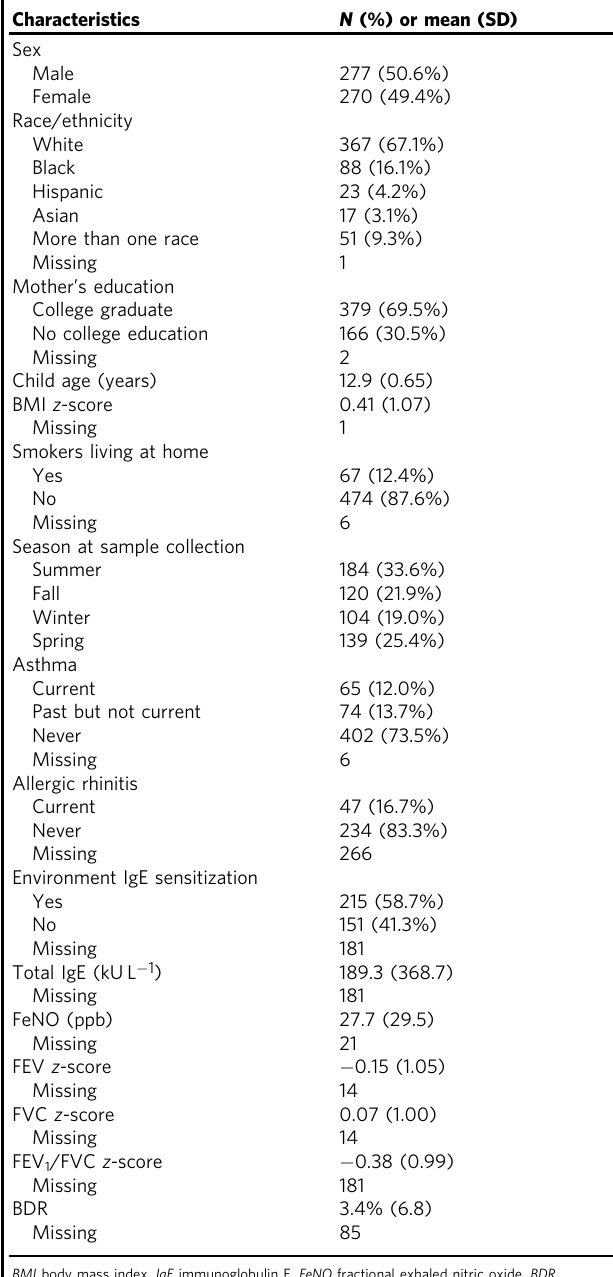
Table 1 Study characteristics of Project Viva participants a